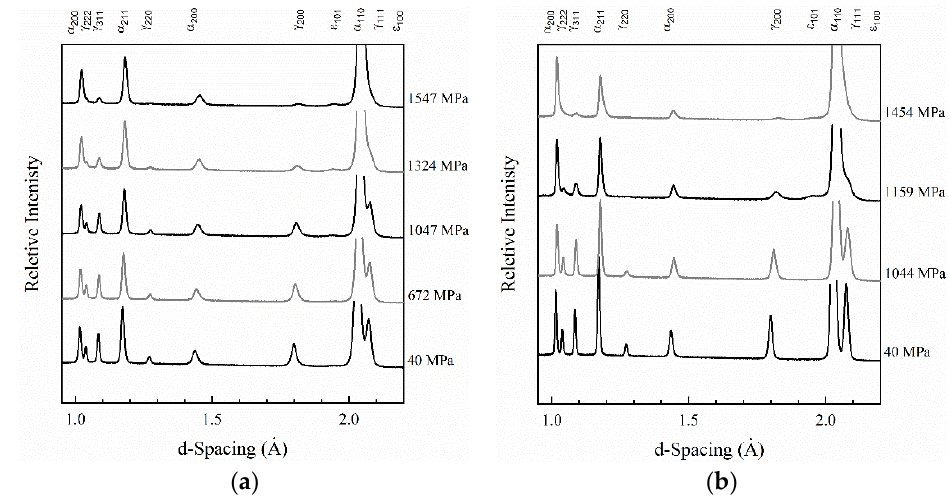
Figure 4. Representative in situ neutron diffraction data during uniaxial deformation for the ( a ) double soaked and ( b ) double soaked plus tempered heat treatment conditions. True stresses at each diffraction condition are indicated.